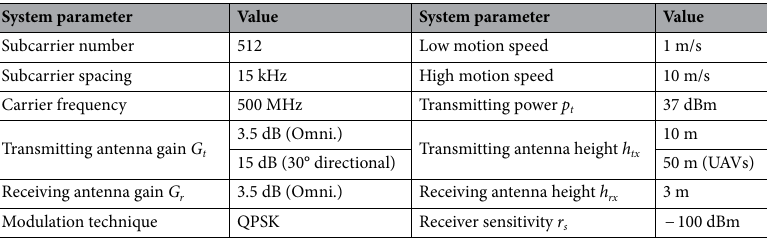
Table 2. The system parameters for transmission distance